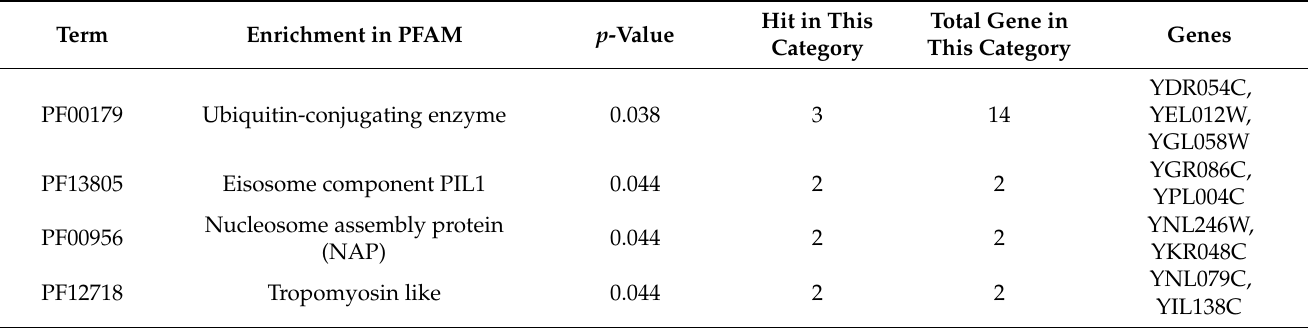
Table 7. Enrichment categories in protein domain analyzed by PFAM for the protein targets of